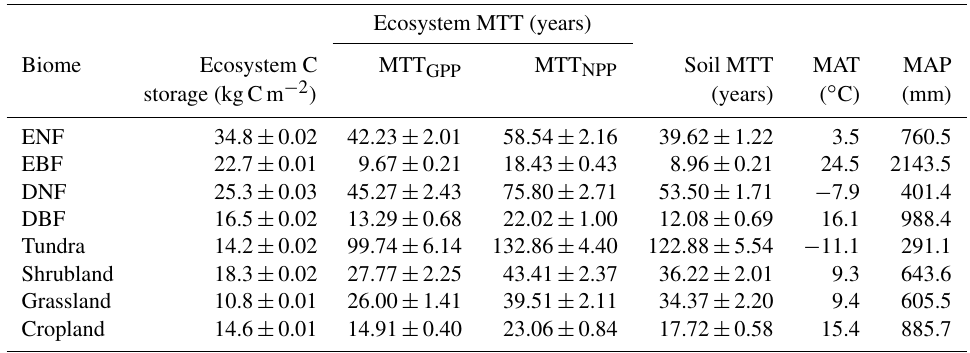
Table 1. The density of ecosystem C storage (kgCm − 2 ) , mean turnover time (MTT, years), mean annual temperature (MAT) and precipita- tion (MAP) for the eight biomes. Ecosystem MTT was calculated based on GPP and NPP.